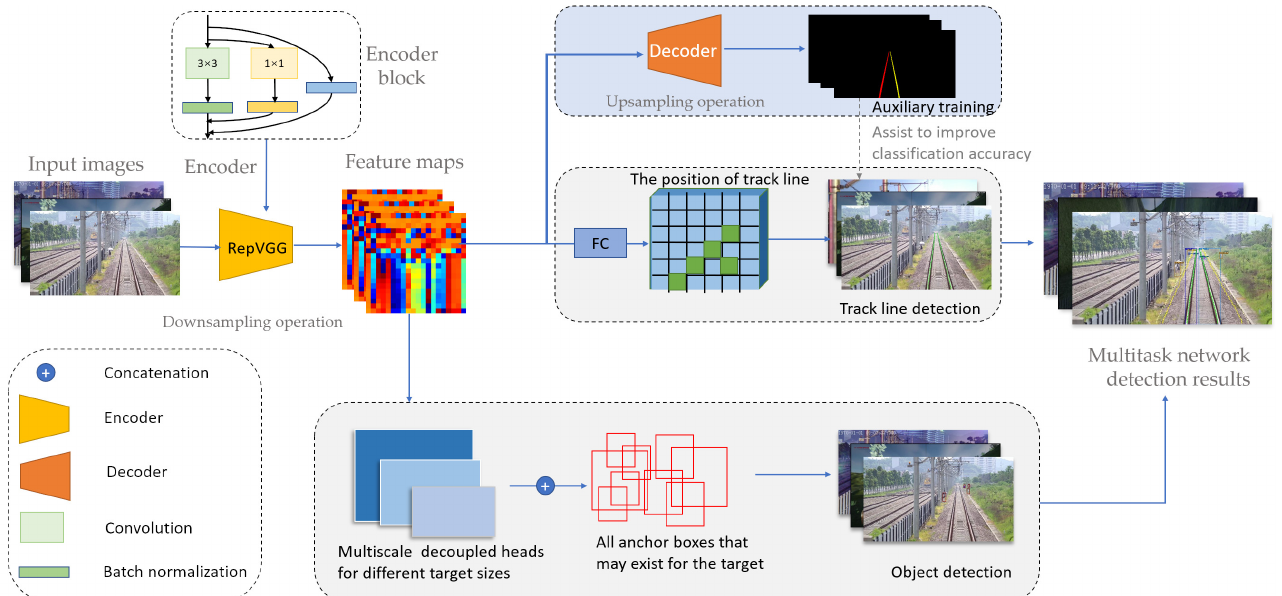
Figure 2. The architecture of the multitask learning network. The loaded images are the input of the shared encoder. Then, the feature map corresponding to the images is obtained by downsampling. The feature map is used as the input for different subsequent tasks. It is, respectively, passed to the segmentation branch, which is an auxiliary training, the track line detection branch that performs track line position prediction, and the target detection branch that performs obstacle detection. Finally, the output results of different branches are combined as the overall network